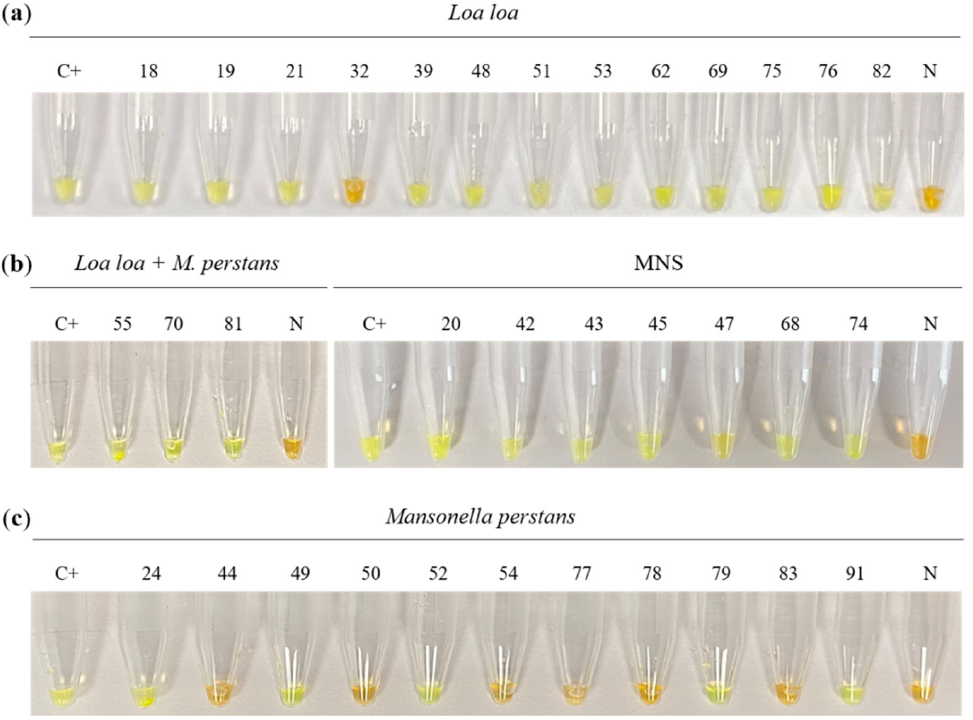
Figure 1. Examination of dried blood samples by conventional colorimetric Loa loa -LAMP. The figure shows the colorimetric visual detection of LAMP results in testing DBS using the SYBR Green I dye-based method: ( a ) Loa loa, Loa loa -microscopy positive samples. ( b ) Loa loa + M. perstans , Loa loa and Mansonella perstans -microscopy positive mixed samples; MNS, microscopy negative samples.